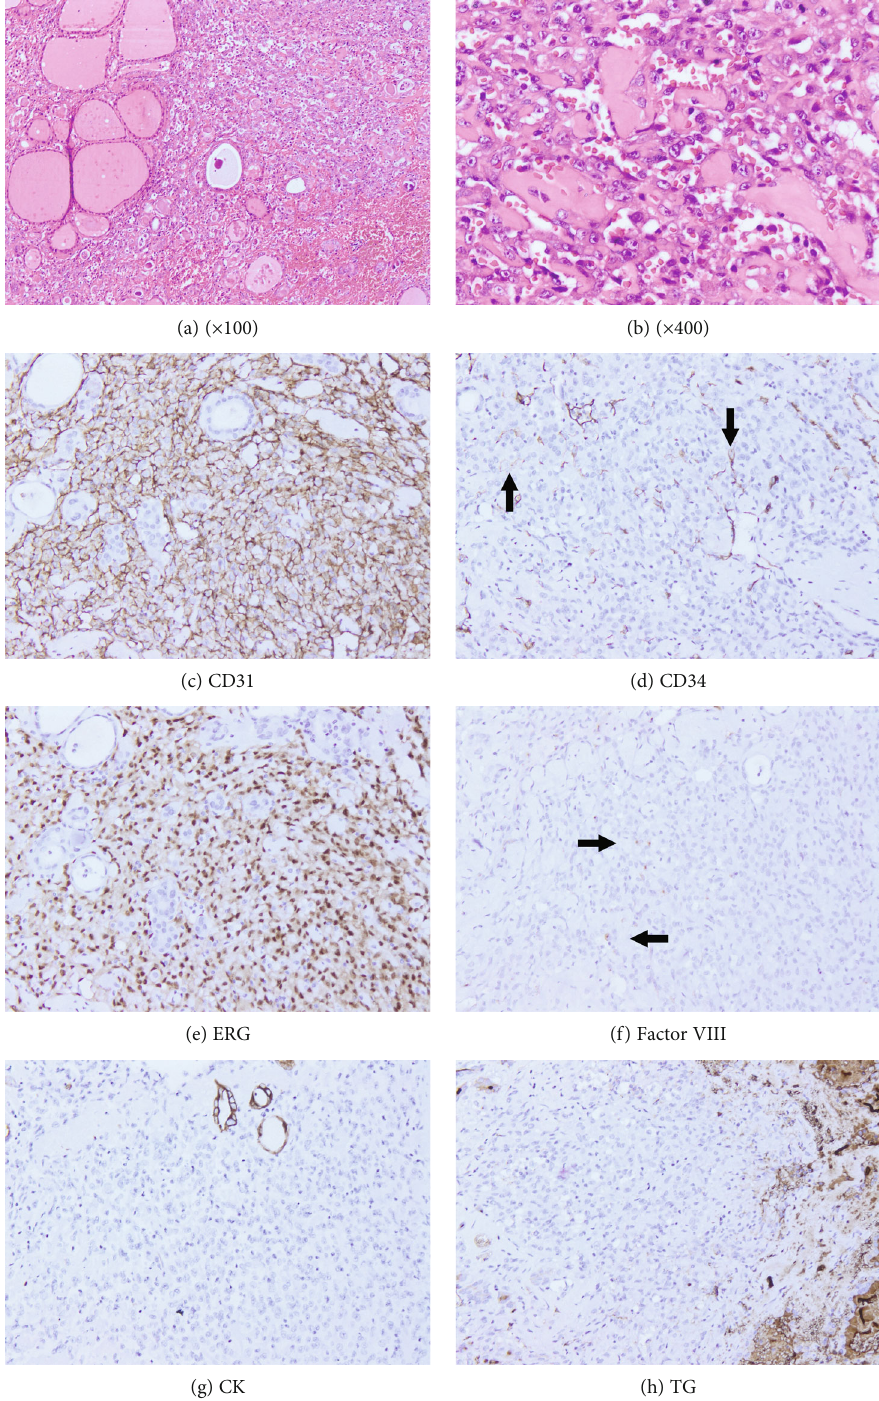
Figure 1: (a) The tumor is hemorrhagic and composed of ramifying and intercommunicating vascular spaces with in fi ltration into adjacent thyroid tissue (Mag.100x). (b) Those tumor cells have large epithelioid and pleomorphic nuclei with clumped chromatin and prominent basophilic nucleoli, and abundant eosinophilic cytoplasm exhibiting occasional intracytoplasmic lumina with identi fi able erythrocytes (Mag.400x). (c) Di ff use membranous and cytoplasmic immunoreactivity for CD31 (Mag.200x). (d) Faint and focal expression of CD34 (Mag.200x). (e) Di ff use nuclear staining for ERG (Mag.200x). (f) Faint and focal cytoplasmic immunoreactivity for Factor VIII-associated antigen (Mag.200x). (g) Negative staining for pancytokeratin in lesional cells (Mag.200x). (h) No expression for thyroglobulin